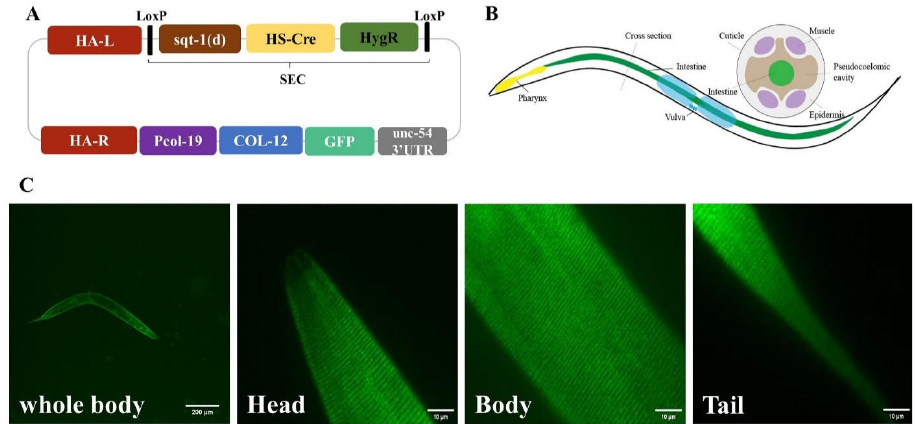
Figure 1. Construction of nematode models. ( A ) Restoration of templates; ( B ) Diagram of a nematode model; ( C ) single copy insertion transgenic nematode P col-19 -COL -12::GFP model parts (Scale bars, 10 μ m).